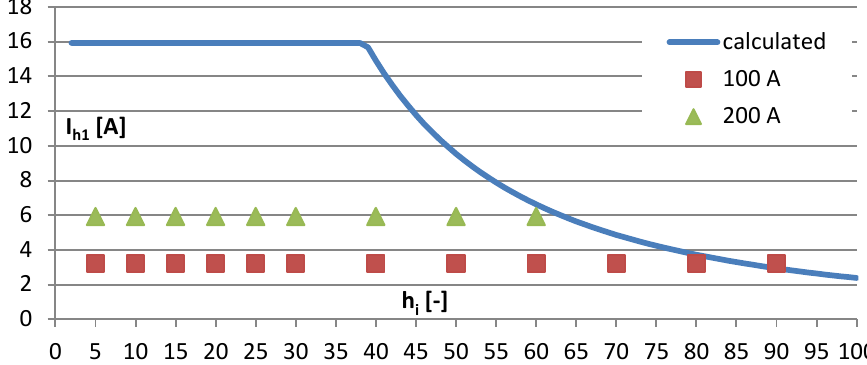
Figure 10. The frequency band of operation of the PWM-based power source for a required rms value of its main component of the output current.